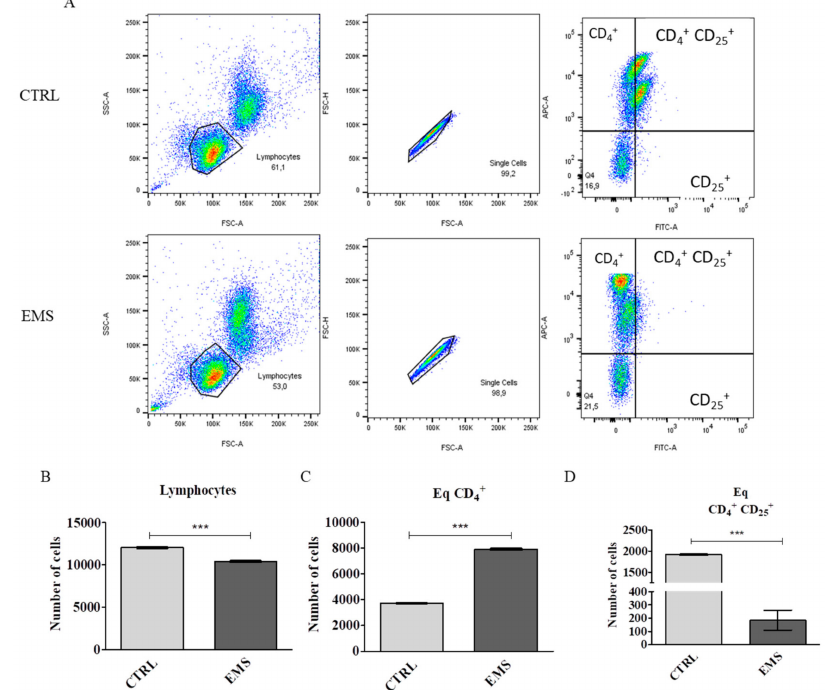
Figure 1. Flow cytometry analysis of CD 4+ CD 25+ regulatory T cells. Representative graphs showing dot plots from flow cytometry analysis ( A ). Total number of lymphocytes was significantly decreased in equine metabolic syndrome (EMS) horses ( B ), while number of CD 4+ cells increased ( C ). Furthermore, EMS horses were characterized by decreased number of T REG in circulating blood ( D ). Results expressed as mean ± S.D. *** p <